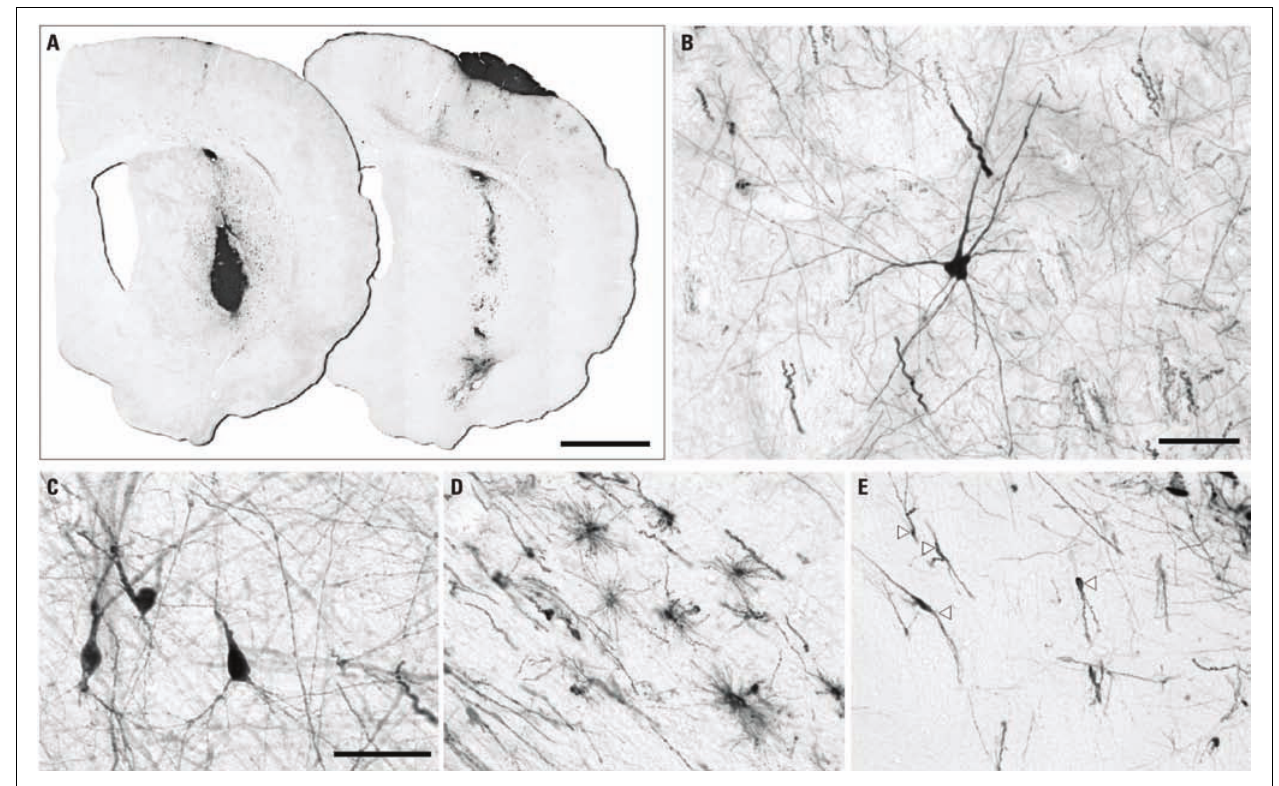
FIGURE 3 | Placement and morphological features of intra-cerbral grafts revealed by immunohistochemistry for GFP 10 weeks after transplantation. (A) In most animals the graft deposit was located in the striatum (left section), although occasionally the majority of the graft core could be found in the cortex (right section), likely due to backflow of cells along the cannula tract. Morphological analysis of